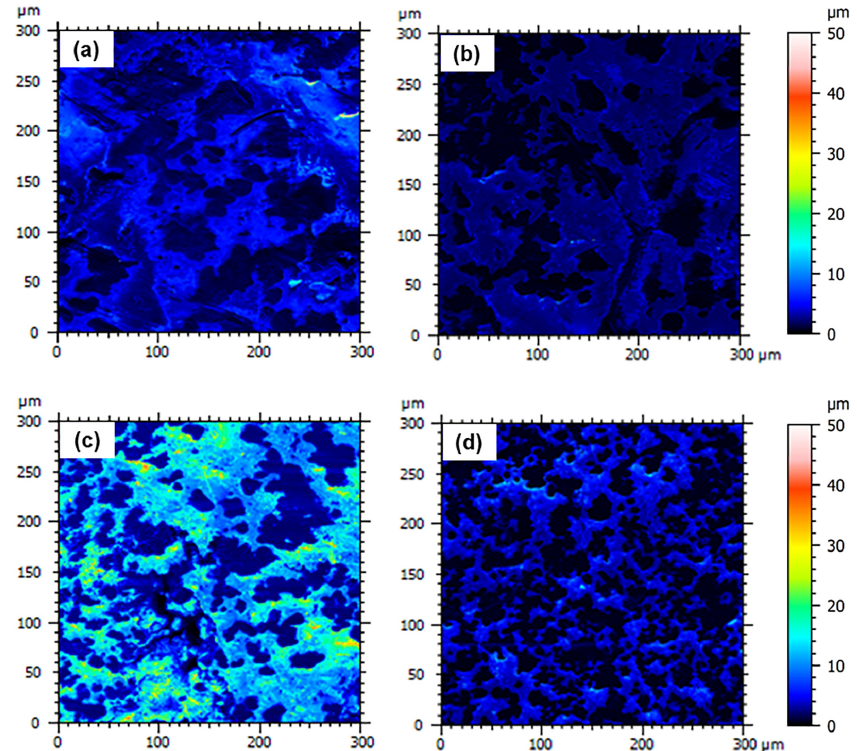
Figure 10. 3D surface reconstruction through SEM image processing of non-irradiated ( left ) and irradiated ( right ) samples of ( a , b ) MDPE/MWCNT 5 wt% and ( c , d ) MDPE/GNP 3 MWCNT 1 20 wt% nanocomposites. Table 7. Surface roughness and relative percentage variation ( ∆ R a /R a ) of MDPE/GNP 5